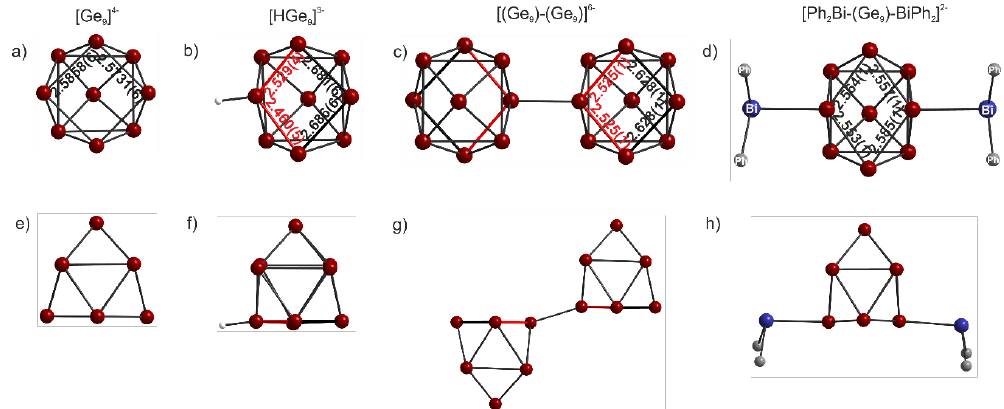
Figure 2. Comparison of different germanide cluster species with view to the basal square plane and rotation by 90°: ( a , e ) [Ge 9 ] 4− cluster in [K-(2,2)diaza-[18]-crown-6]K 3 Ge 9 ·2en; ( b , f ) [HGe 9 ] 3− in [Rb([2.2.2]crypt)] 2 [Rb([18]crown−6)][HGe 9 ]·4NH 3 ; ( c , g ) [(Ge 9 -Ge 9 )] 6− in Cs 4 (K-crypt) 2 [(Ge 9 )-(Ge 9 )]·6en